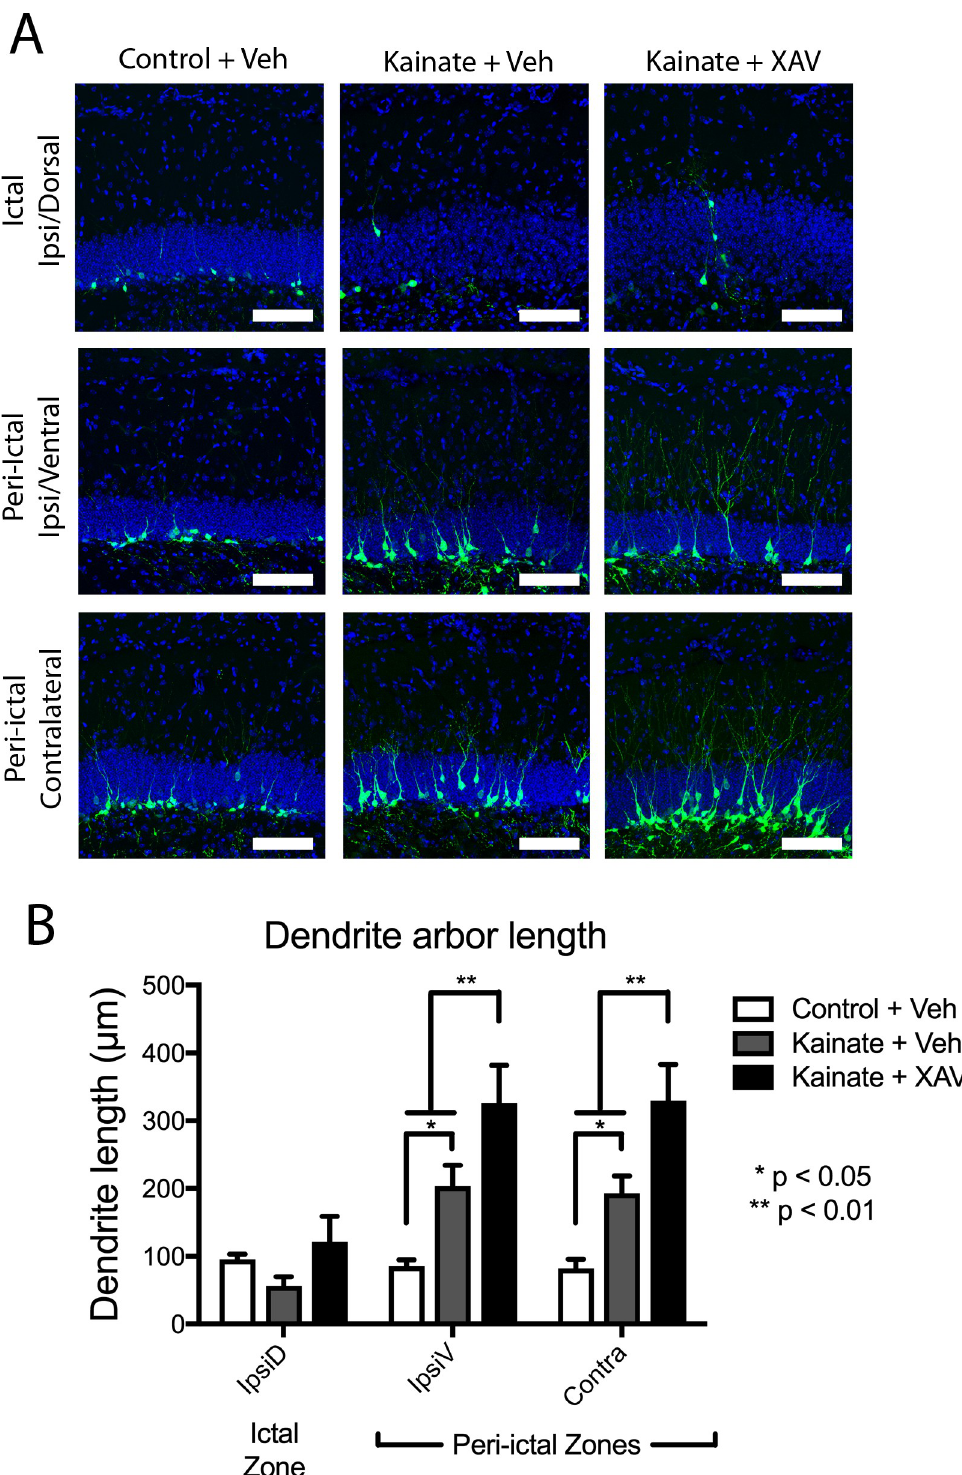
Fig 4. Post-kainate increase in newborn granule cell dendrite length is augmented by Wnt inhibition. (A) Images of POMC-EGFP + adult-born dentate granule cell neurons from indicated hippocampal regions two weeks after intrahippocampal kainate or saline injection, followed by daily systemic treatment with XAV939 vs. vehicle control. Scale bars 100 μ m. (B) In peri-ictal regions, mean dendritic arbor length per eGFP+ cell increased significantly after kainate- induced seizure in peri-ictal zones, and was further increased by XAV939 treatment. https://doi.org/10.1371/journal.pone.0215789.g004 PLOS ONE | https://doi.org/10.1371/journal.pone.0215789 October 9,